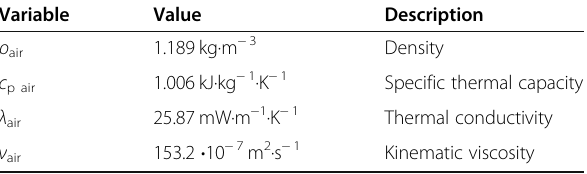
Table 3 Selected material values for the surrounding fluid Variable Value